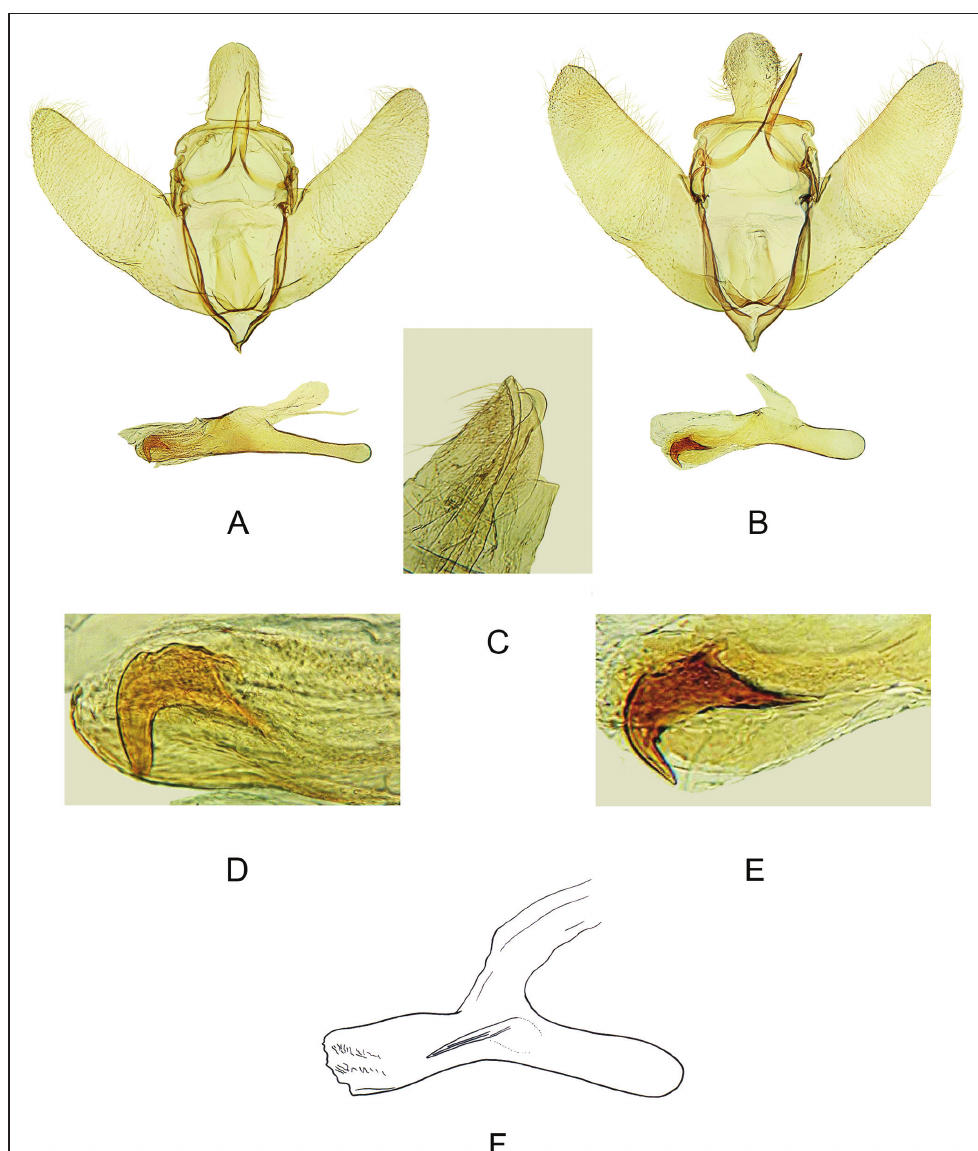
Figure 2. Male genitalia in A. gambronensis sp. n. ( A, D ) and A. kurdistanella Amsel ( B, C, E ), and phal - lus in S. robustus ( F ). A, B ) main armature and phallus, C ) distal part of uncus and gnathos in lateral view, D, E ) distal part of phallus in lateral view, showing cornutus.